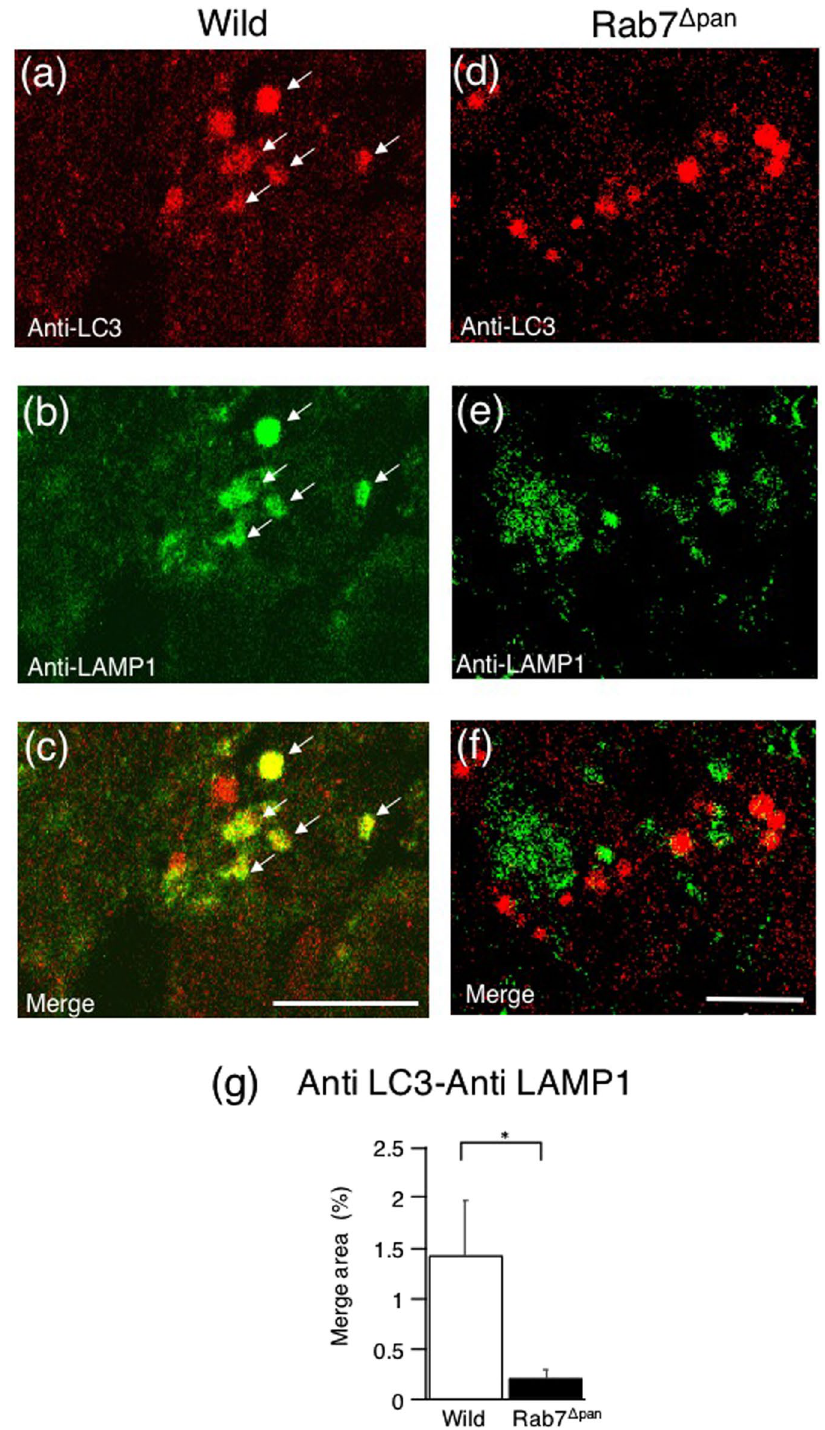
Figure 10. Immunofluorescence images of pancreatic acinar cells with caerulein-induced acute pancreatitis double-stained with anti-LC3 and anti-LAMP-1 antibodies. The yellow signals indicate the colocalization of LC3 and LAMP-1 (arrows). Scale Bars: 10 µ m. ( g ) Quantification of the merged signals of LC3 and LAMP1 (yellow signals) in immunofluorescence images. P * <